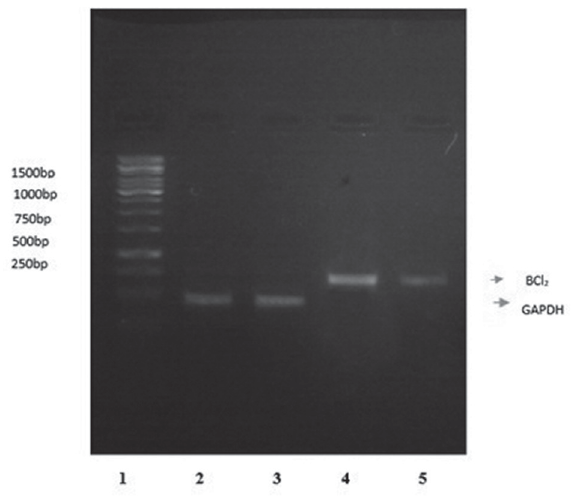
gene 2 gene 2 gene expression 2